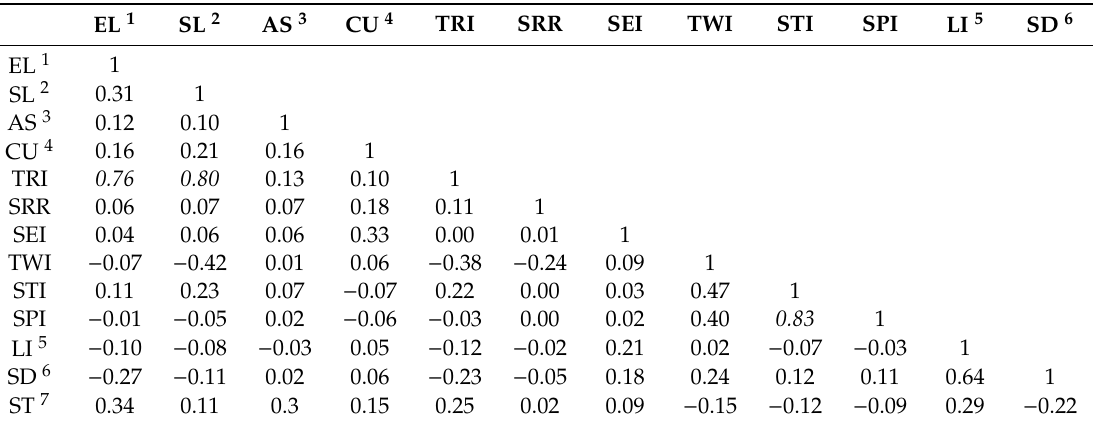
Table 2. Pearson’s correlation between pairs of landslide predisposing factors.